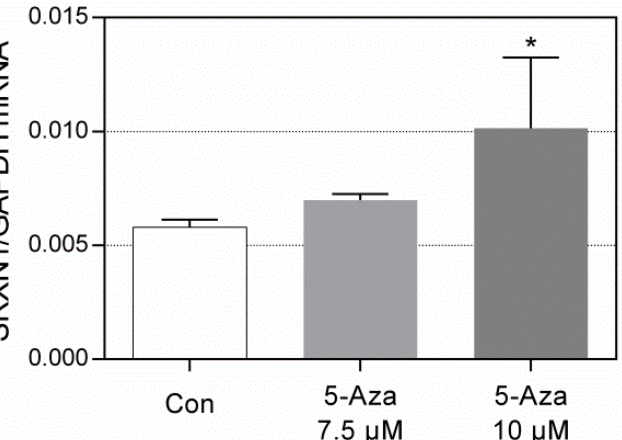
Figure 2. SRXN1 transcription can be modulated by DNA methylation as illustrated by the changes in the mRNA expression level of the SRNX1 gene estimated by RT-qPCR after 72 h treatment of HT29 cells with 7.5 or 10 µM 5-azacitidine (5-Aza). The results are means ± SD of three biological replicates. Statistical analysis was carried out with one-way ANOVA with Dunnett’s test; (*)— p ≤ 0.05. Abbreviations: C, (+)-catechin; Con, control; EC, ( − )-epicatechin; EGC, ( − )-epigallocatechin; ECG, ( − )-epicatechin gallate; EGCG, ( − )-epigallocatechin gallate; GSH, glutathione. The gene for SRXN1 is located on the minus strand of chromosome 20, extending from position 646,615 to 653,200 (NCBI RefSeq NC_000020.11). According to the EMBOSS CpGplot, the human SRXN1 contains a 706 bp long CpG island that covers the region from 652,858 to 653,032, i.e., − 537 to +169, with regard to the position of the transcription start site (TSS) marked as +1 (NCBI RefSeq NM_080725.3) (Figure 3). In order to evaluate the e ff ect of catechins on the DNA methylation pro fi le of CpG island within the promoter the SRXN1 gene, MSP analysis of one (M1/U1) and HRM analysis of two selected regions (M1/U1 and M3/U3) were performed. Positions of the primers used for DNA methylation analysis are shown in Figure 3.